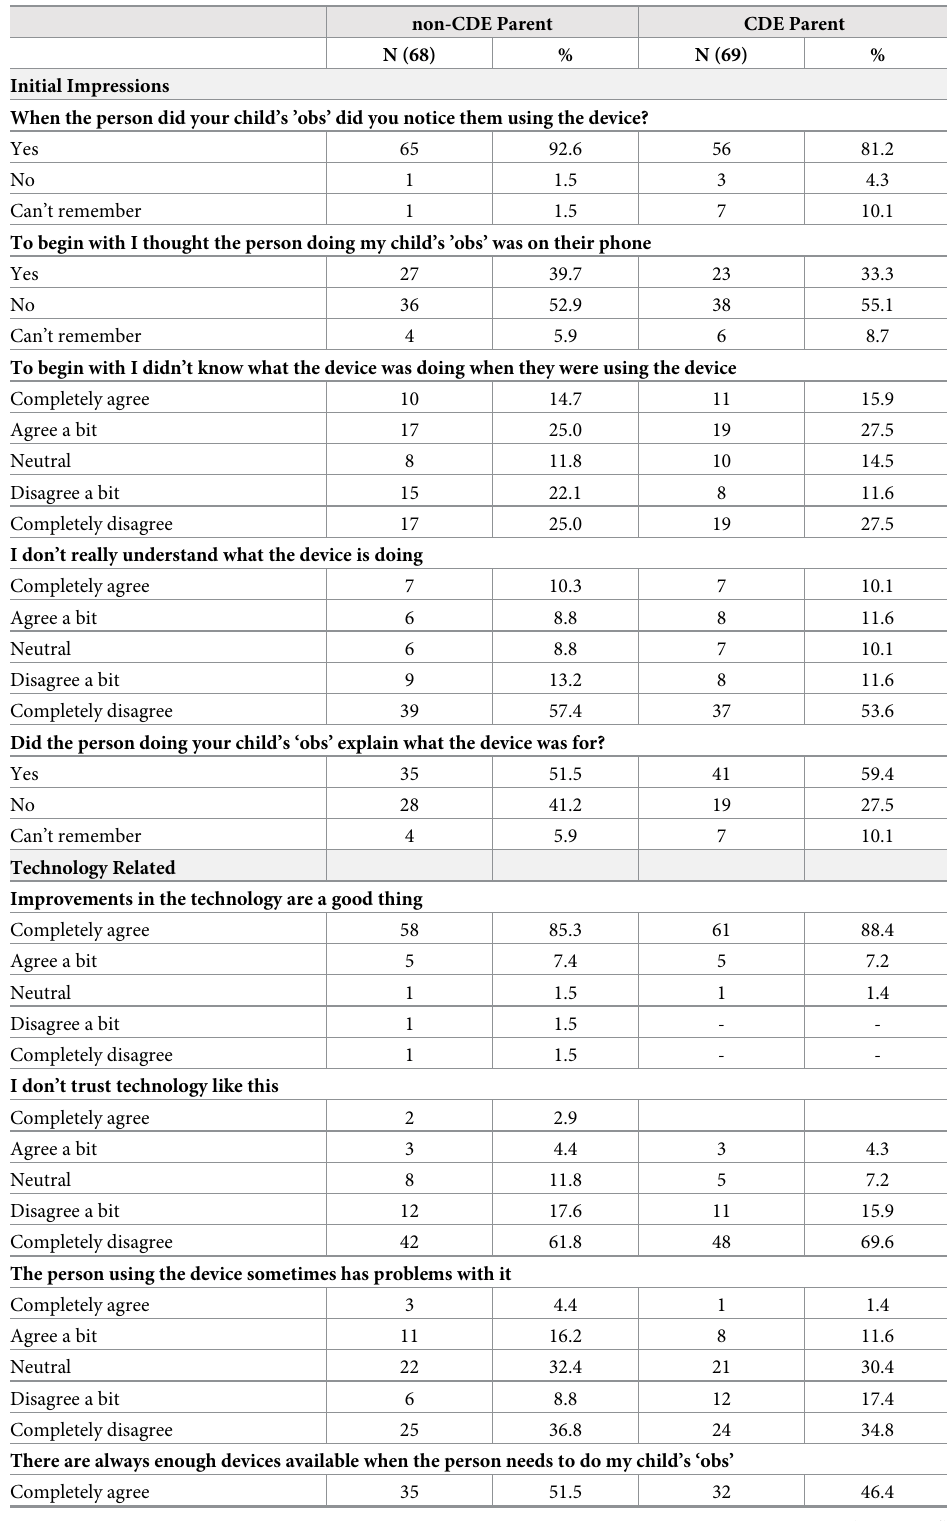
Table 4. Parents’ responses to